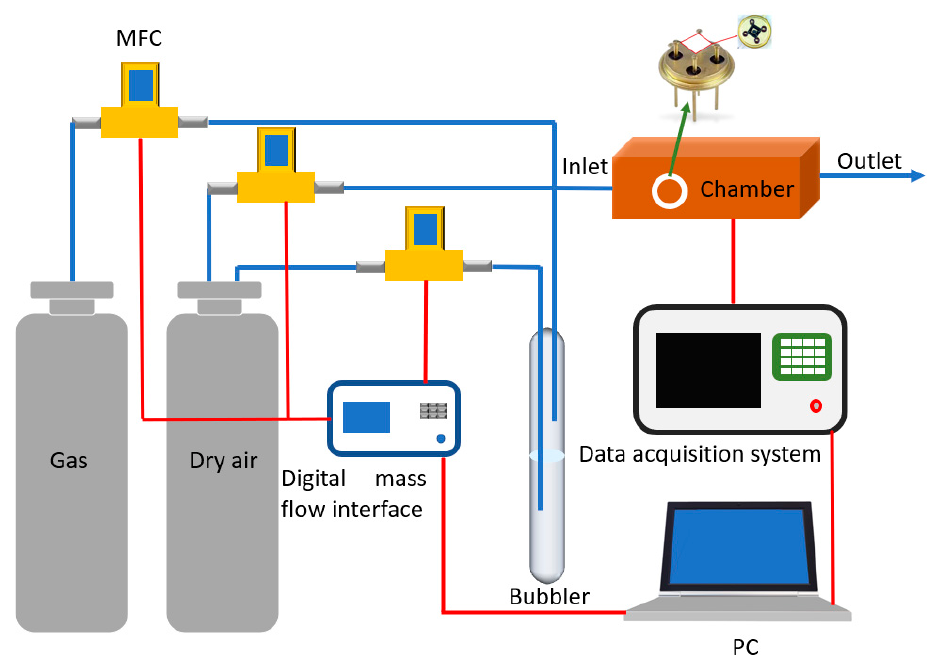
Figure 1. Scheme of the apparatus of the gas sensor characterization system.